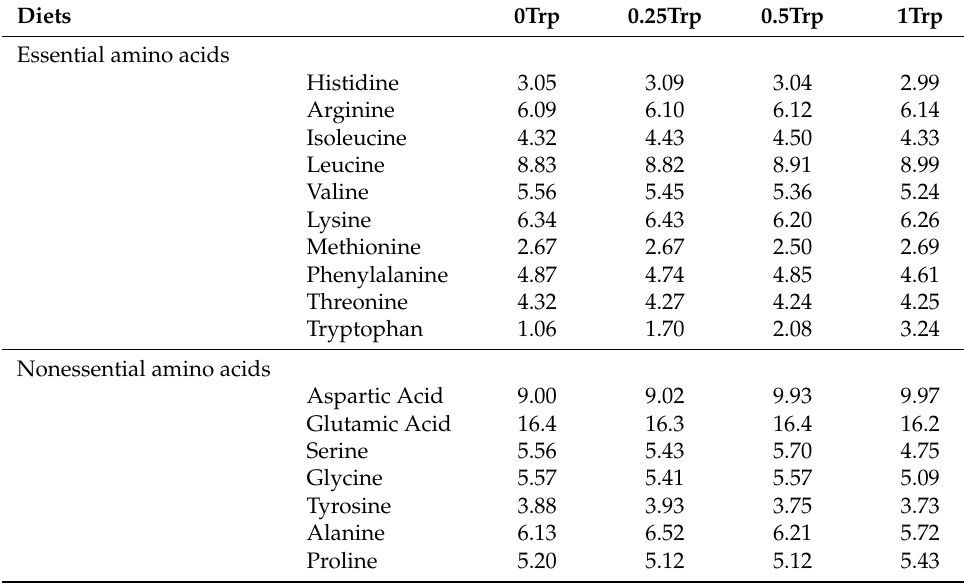
Table 2. Amino acid composition (g 16 g − 1 N) of the experimental diets.